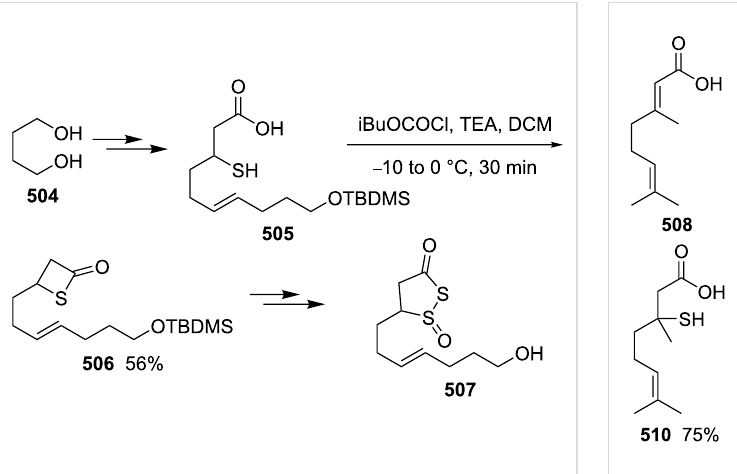
Scheme 117: Synthesis of 4-substituted thietan-2-one via the intramo- lecular thioesterification of 3-mercaptoalkanoic acid.